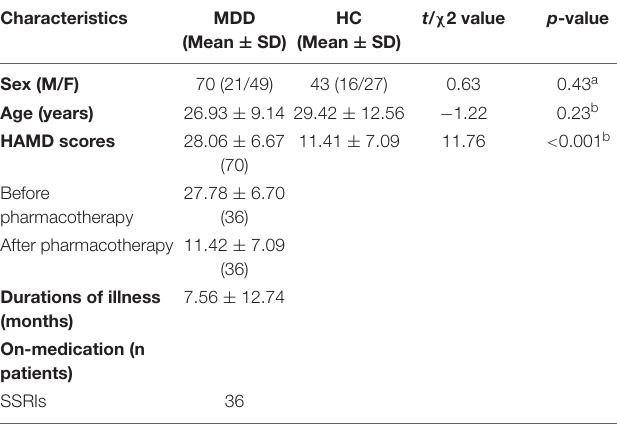
TABLE 1 | Demographic data and group